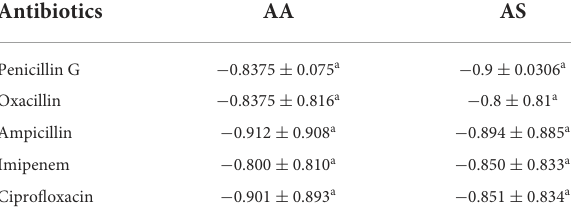
TABLE 5 Comparative unit (means ± SD) change in minimum inhibitory concentration ( µ g/ml) of antibiotics used in combination with AA and